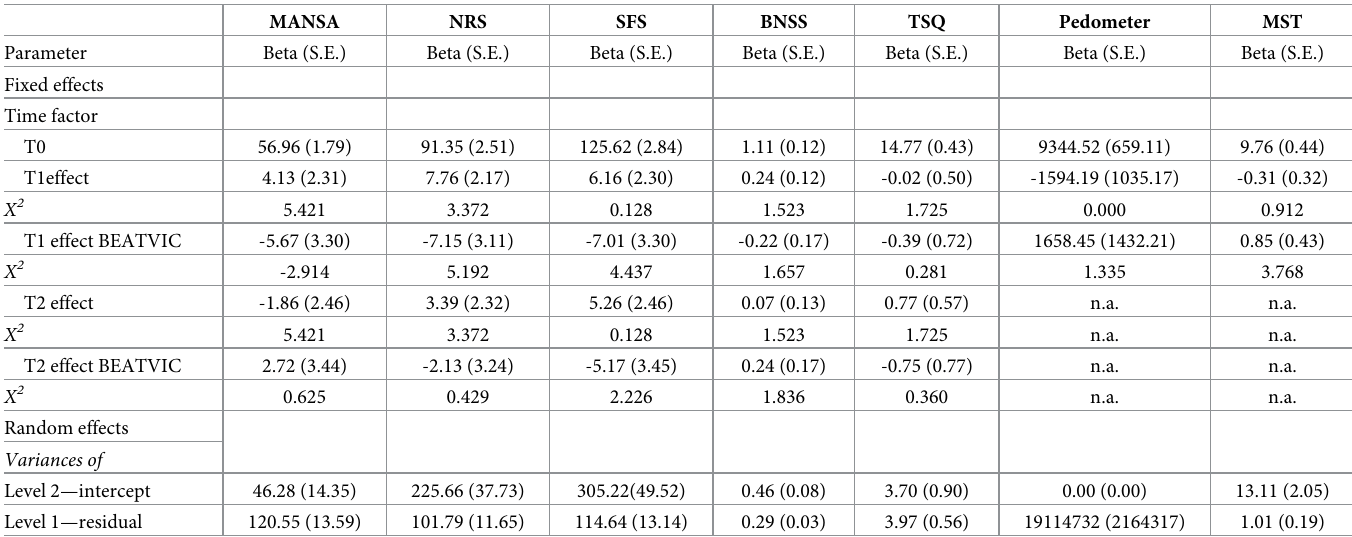
Table 5. Fixed and random effects on secondary